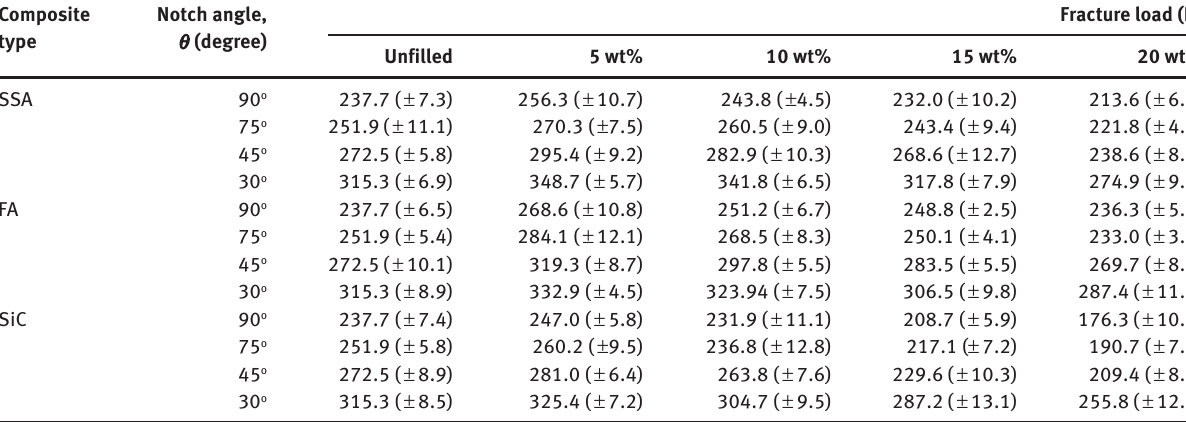
Table 5: Fracture loads of TPB test for SENB specimens. Composite type